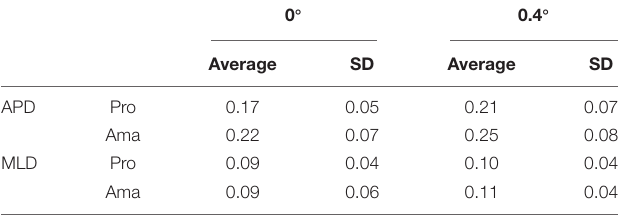
TABLE 4 | Average variable errors in final ball position.